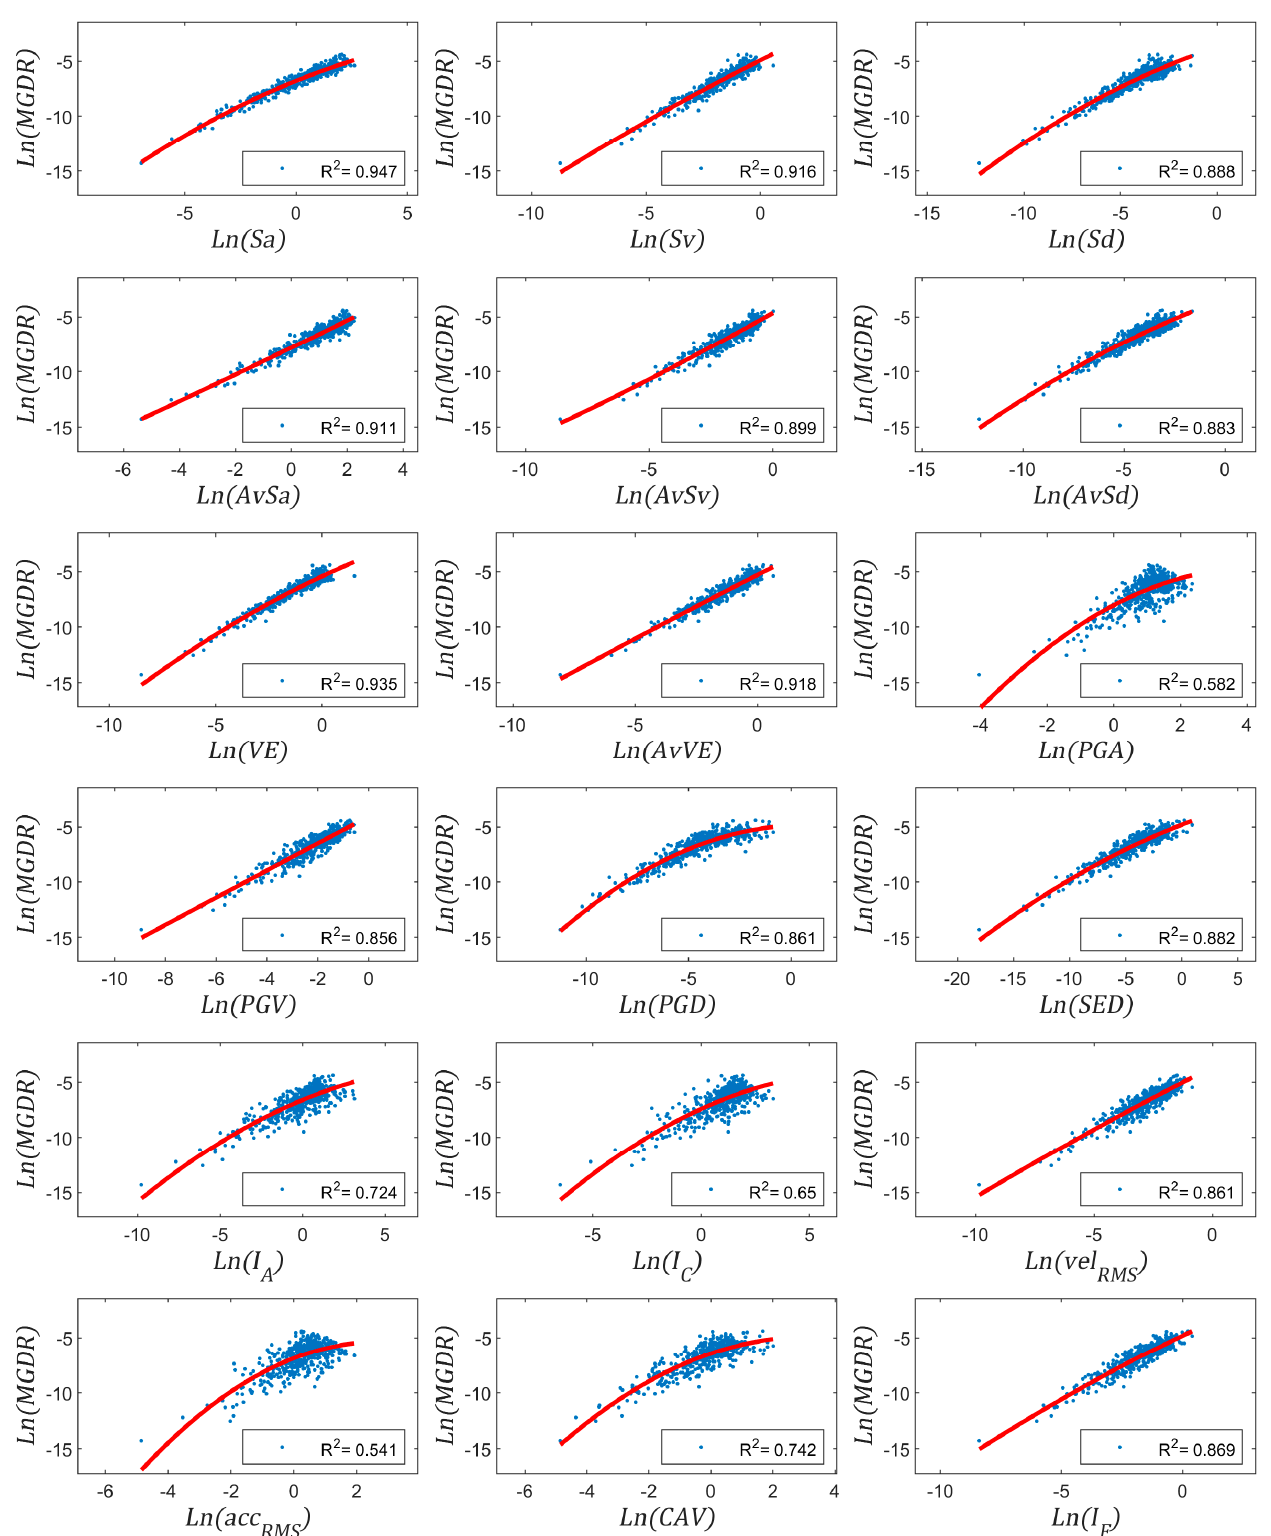
Figure 9. Correlation coefficient between IMs and MGDR in the log-log space for far-fault records.